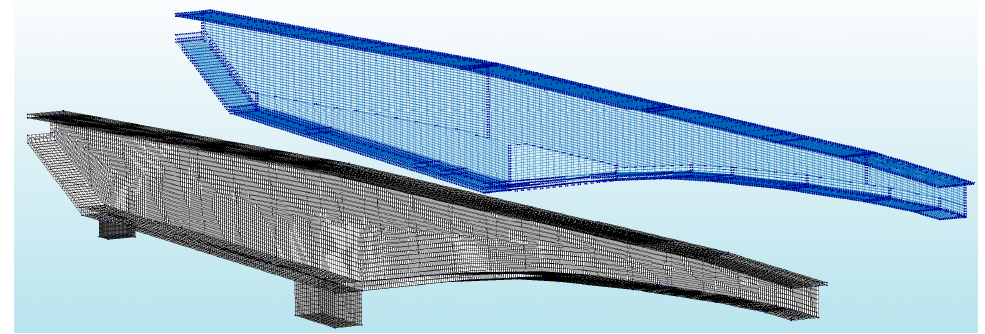
Figure 17. 3D FE model of Koror–Babeldaob Bridge.